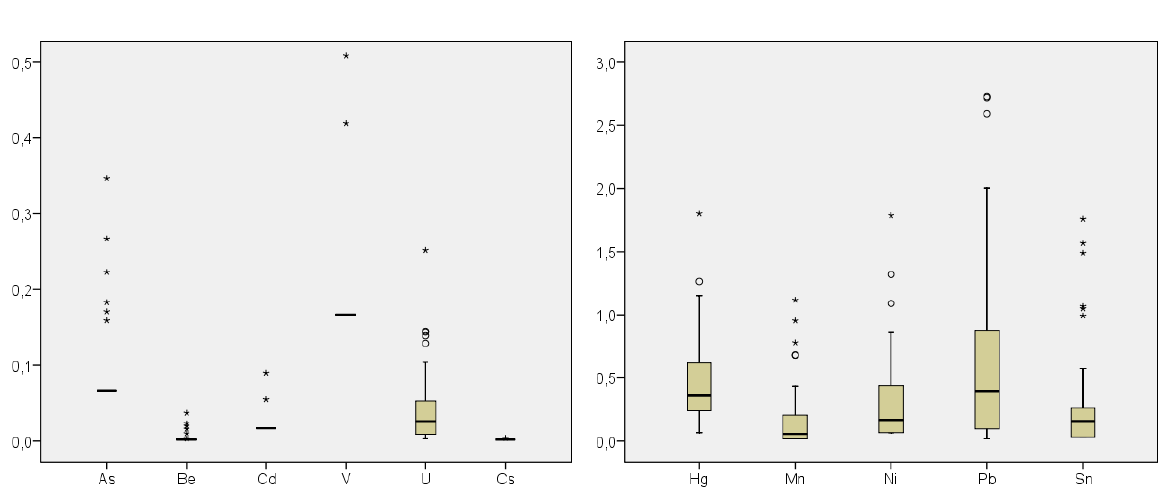
Figure 1. Metal concentrations (mean values in µg/g) in hair samples of children living in the Flix area (Catalonia, Spain) ( n = 53). Outliers (>1.5-box length below the 25th percentile or above the 75th percentile) are shown as circles, while extreme cases (>3-box length below the 25th percentile or above the 75th percentile) are identified as